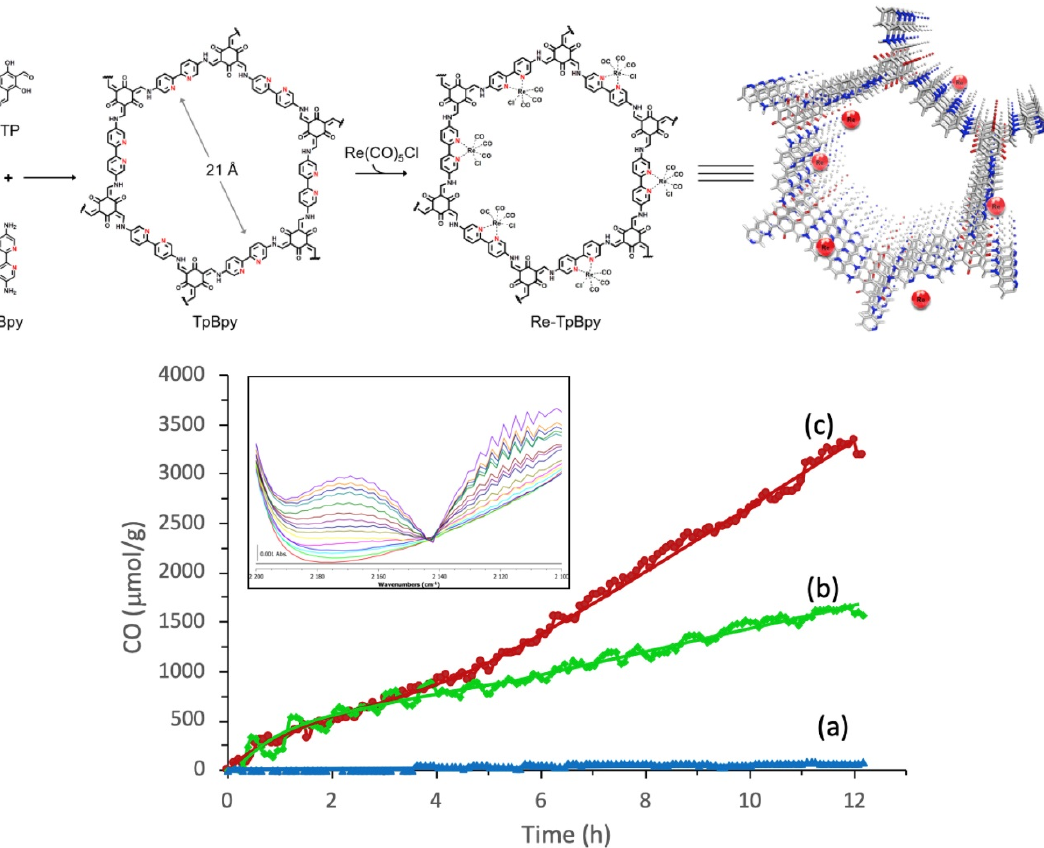
Figure 5. Top : Illustration for the construction steps of TpBpy and Re-TpBpy-COF. Down : Time course of CO production during photocatalytic CO 2 reduction on ( a ) TpBpy-COF, ( b ) Re-Bpy, and ( c ) Re-TpBpy-COF photocatalysts under visible light irradiation. Insert: evolution of the CO vibration band during the CO 2 reduction on Re-TpBpy-COF (time resolution 1 h / spectrum). Copied with permission from Elsevier 2019 [34].